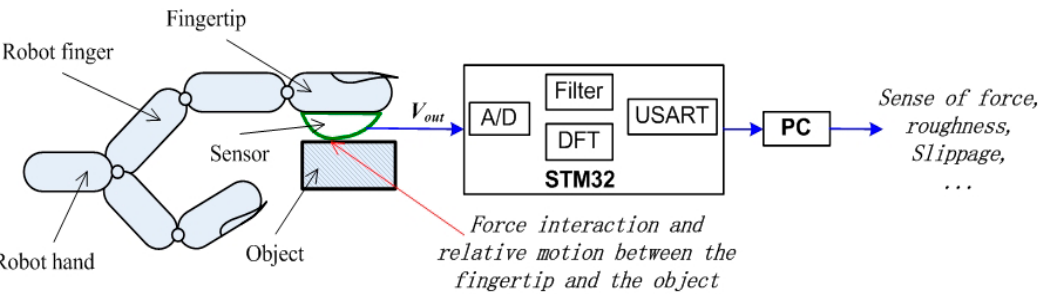
Figure 2. The diagram of the pneumatic sensor’s construction and applications.